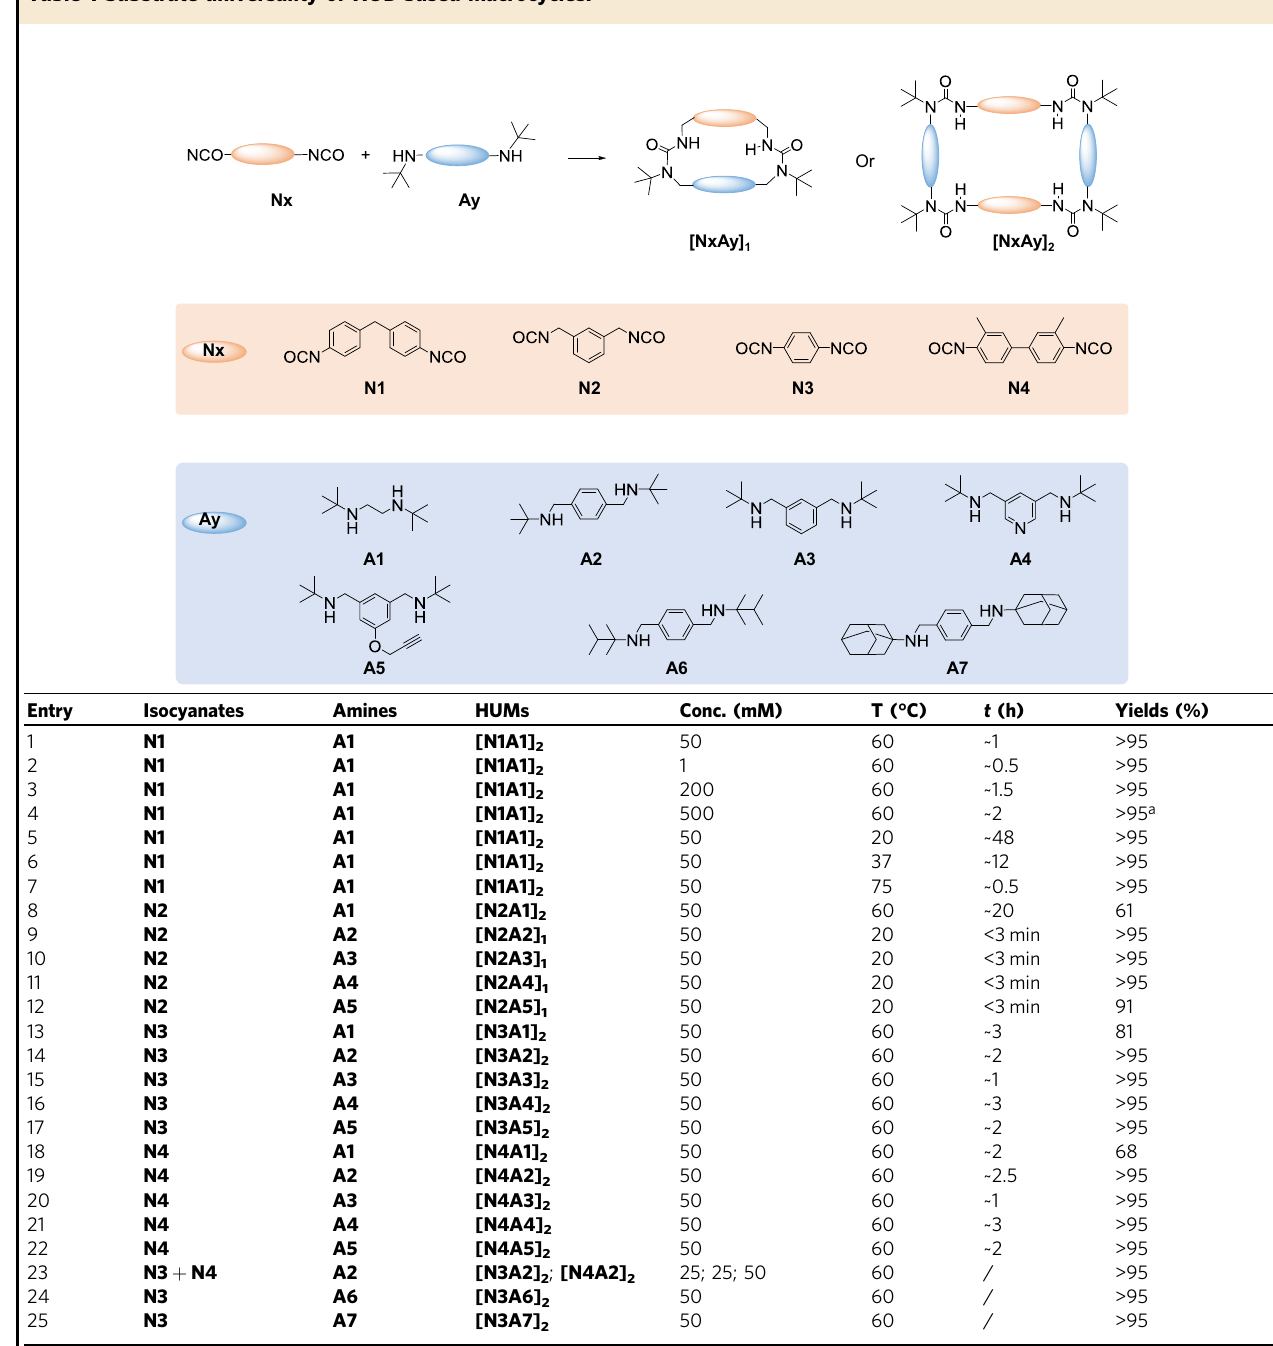
Table 1 Substrate universality of HUB based macrocycles.